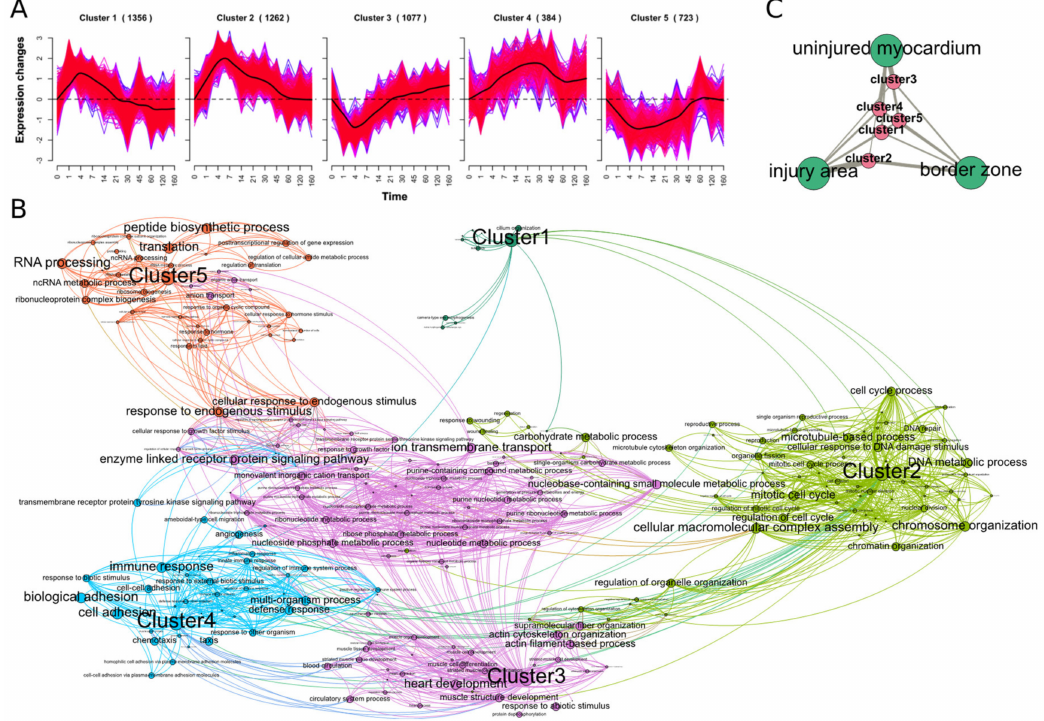
Figure 4. ( A ) Soft-clustering of log2FC over time. Black lines visualize the average dynamics of the clusters. ( B ) Gene set enrichment analysis (Fisher’s Test) of genes from every cluster. Gene sets are connected by an edge if they share 30% of genes. ( C ) Association of clusters to the different profiles after cryoinjury identified by Wu et al.